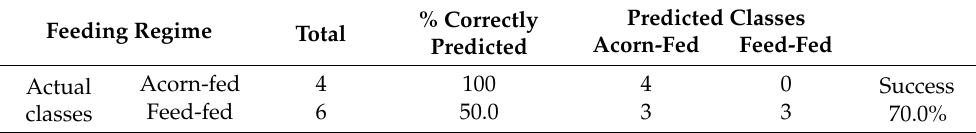
Figure 5. Score plots of LDA calibration models for ( a ) feeding regime discrimination and ( b ) ternary differentiation using device B. Table 3. Results of feeding regime Raman chemometric classification model with device B.